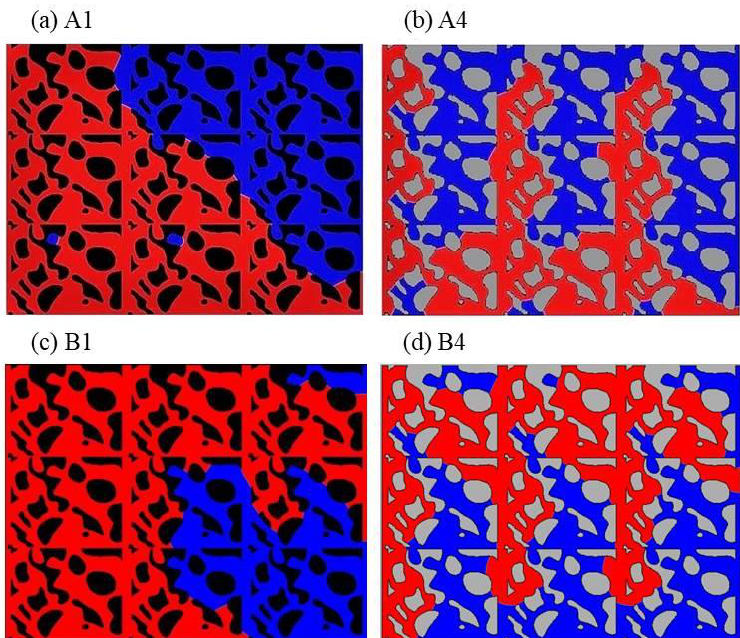
Figure 6. Gas and water distributions (gas-wet solid in gray, water-wet solid in black, and water in blue and gas in red) in porous structures with homogenous wettability at the quasi-steady state: ( a ) A1 — full water-wet, 𝑟 𝑔−𝑤 = 0; ( b ) A4 — full gas-wet, 𝑟 𝑔−𝑤 = 1; ( c ) B1 — full water-wet, 𝑟 𝑔−𝑤 = 0; ( d ) B4 — full gas-wet, 𝑟 𝑔−𝑤 = 1.